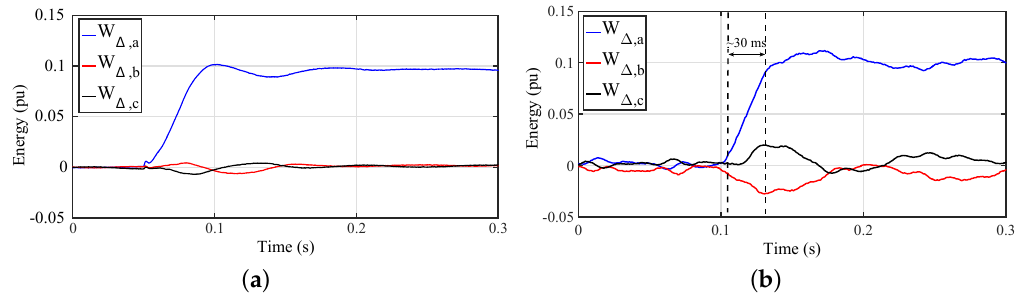
Figure 11. Arm energy controller step response ( a ) in simulation and ( b ) experimental